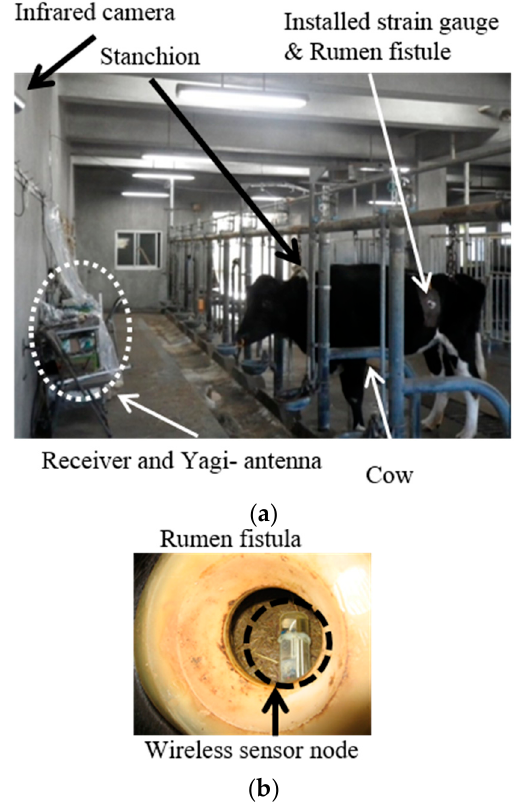
Figure 4. Experimental environment ( a ) and the rumen fistula ( b ).